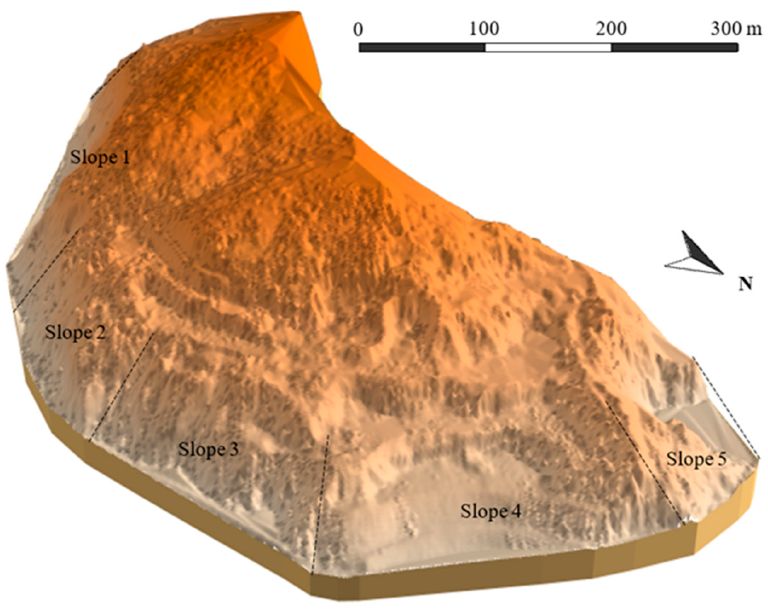
Figure 2. Three-dimensional model of the Nanshanju slope.